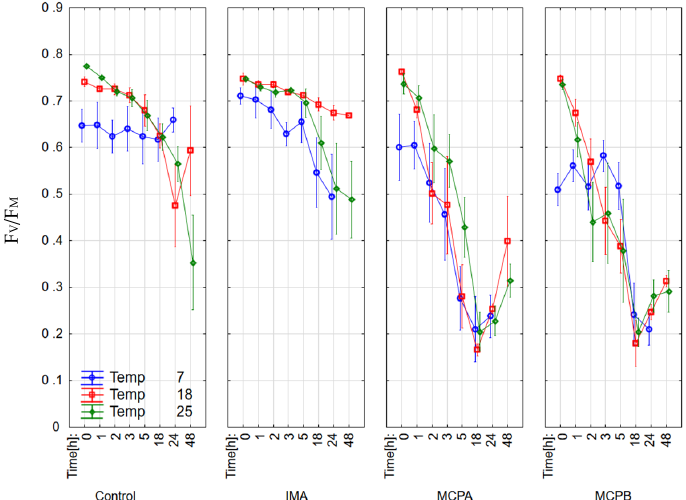
Figure 3. Capacity of photochemical reactions of photosynthesis in PSII (F V /F M ) as affected by MCPA, MCPB and IMA in G. orientalis cultivated at three different temperatures (7, 18 and 25 °C). Data points represent means of five replicates ± standard deviation. The replicates were five leaves, each on a different plant.